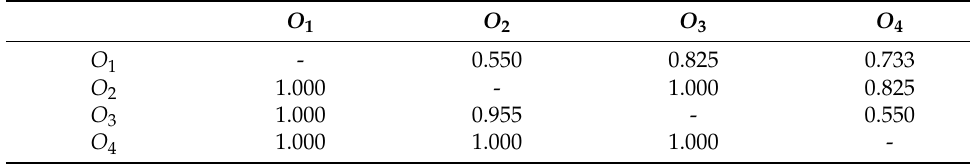
Table 5. The discordance matrix.